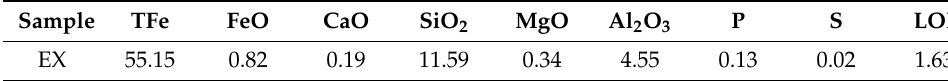
Table 3. Chemical composition of the EX iron ore (wt.%) [28].